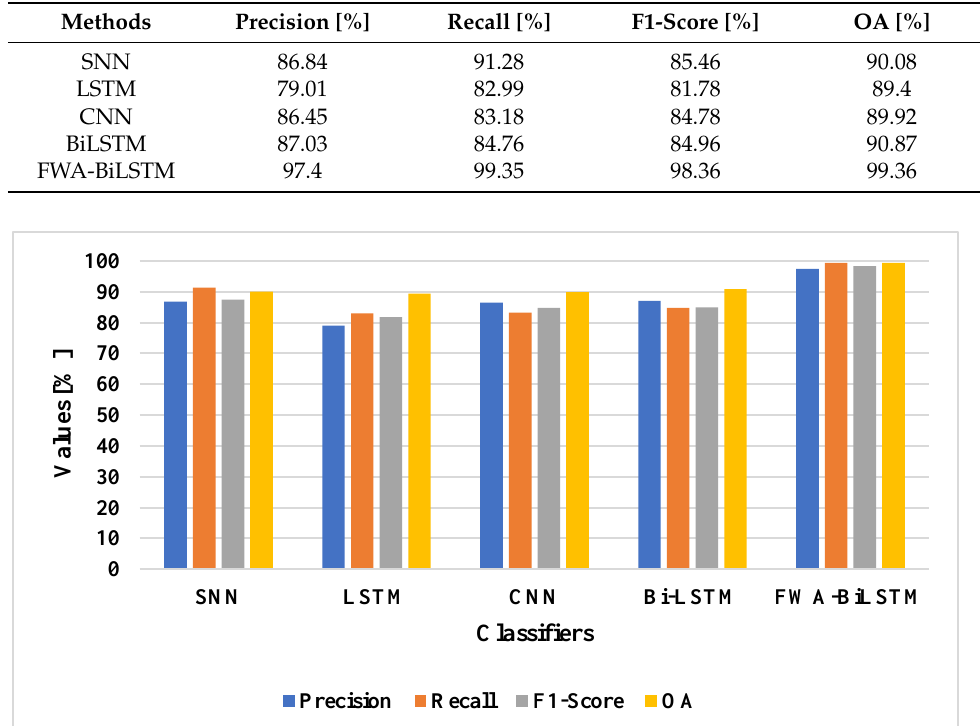
Figure 9. Classifier compared with FWA-BiLSTM model on SVD dataset.